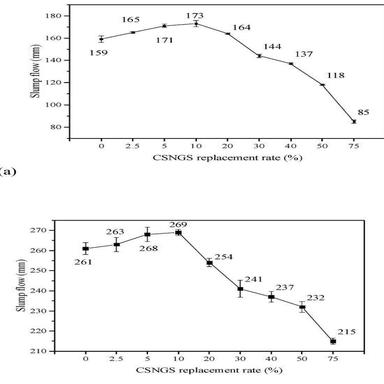
Effects of CSNGS on the slump flow of composite cementitious materials, (a) paste and (b) mortar.